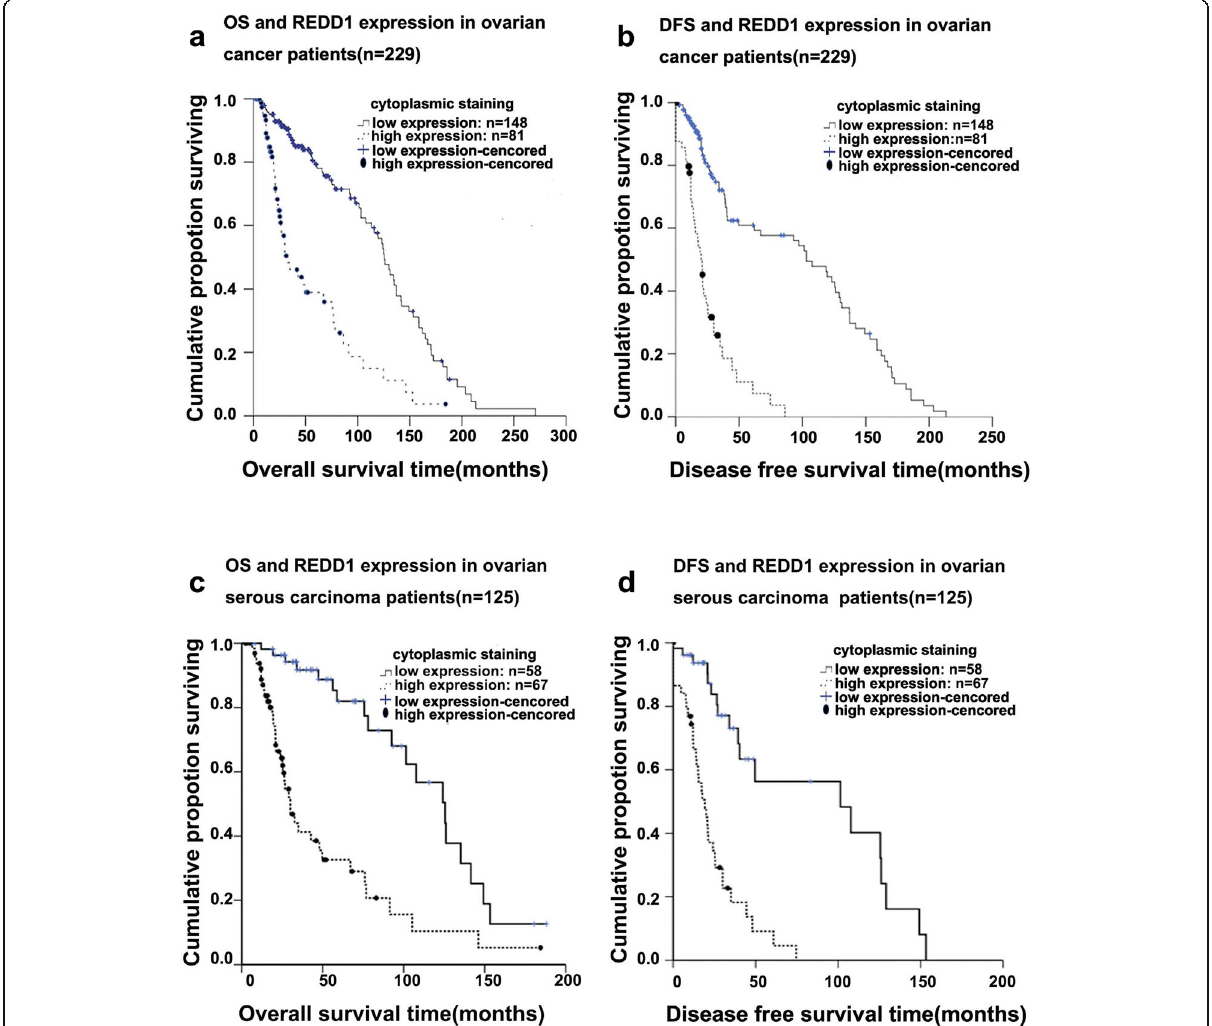
Fig. 2 Kaplan – Meier survival curves ovarian carcinoma patients grouped by low and high REDD1 expression levels. a OS curves in all patients with ovarian cancer ( n = 229). b DFS curves in all patients ( n = 229). c OS curves in patients with ovarian serous carcinoma ( n = 125). d DFS curves in patients with ovarian serous carcinoma ( n =